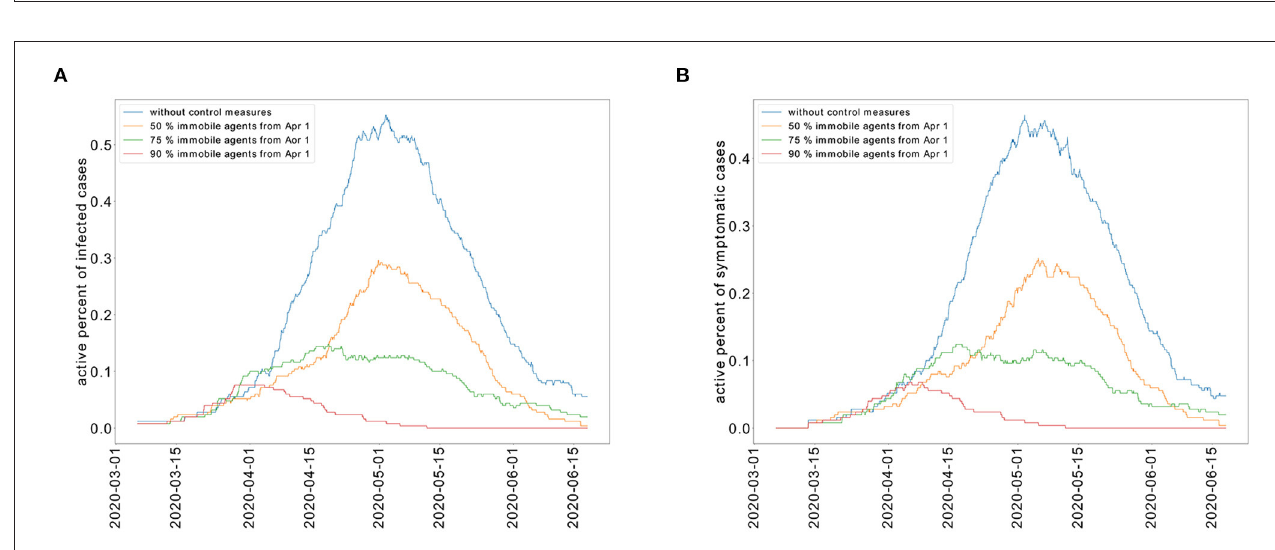
FIGURE 7 | Restricted population movement flattens the epidemic curve for the active percent of infected individuals (A) and symptomatic individuals (B)